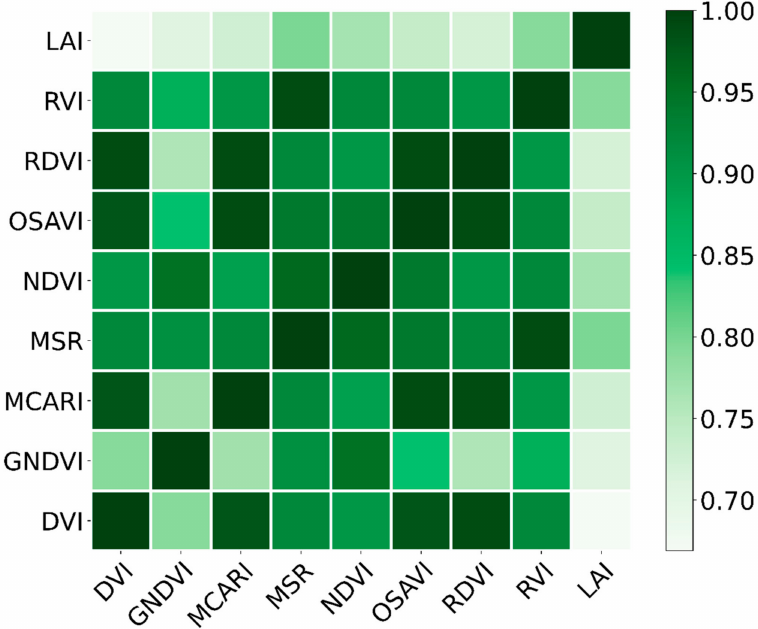
Figure 3. Correlations between the vegetation indices and peanut LAI during the whole growth period. p = 0.01, the correlation is